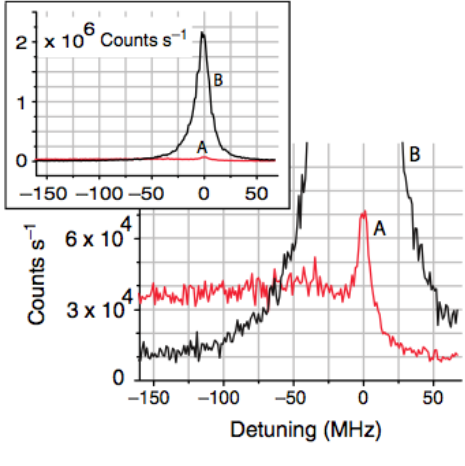
Figure 5. Laser induced fluorescence spectra from Cs measured through an optical nanofiber for the closed-cycle transition, 6S F = 4 ↔ 6P F = 5. Traces A and B correspond to without and with the effect of violet laser irradiation, respectively. The violet irradiation was used to remove Cs that had adhered to the surface of the fiber. Reprinted with permission from [58]. Copyright 2008 Institute of